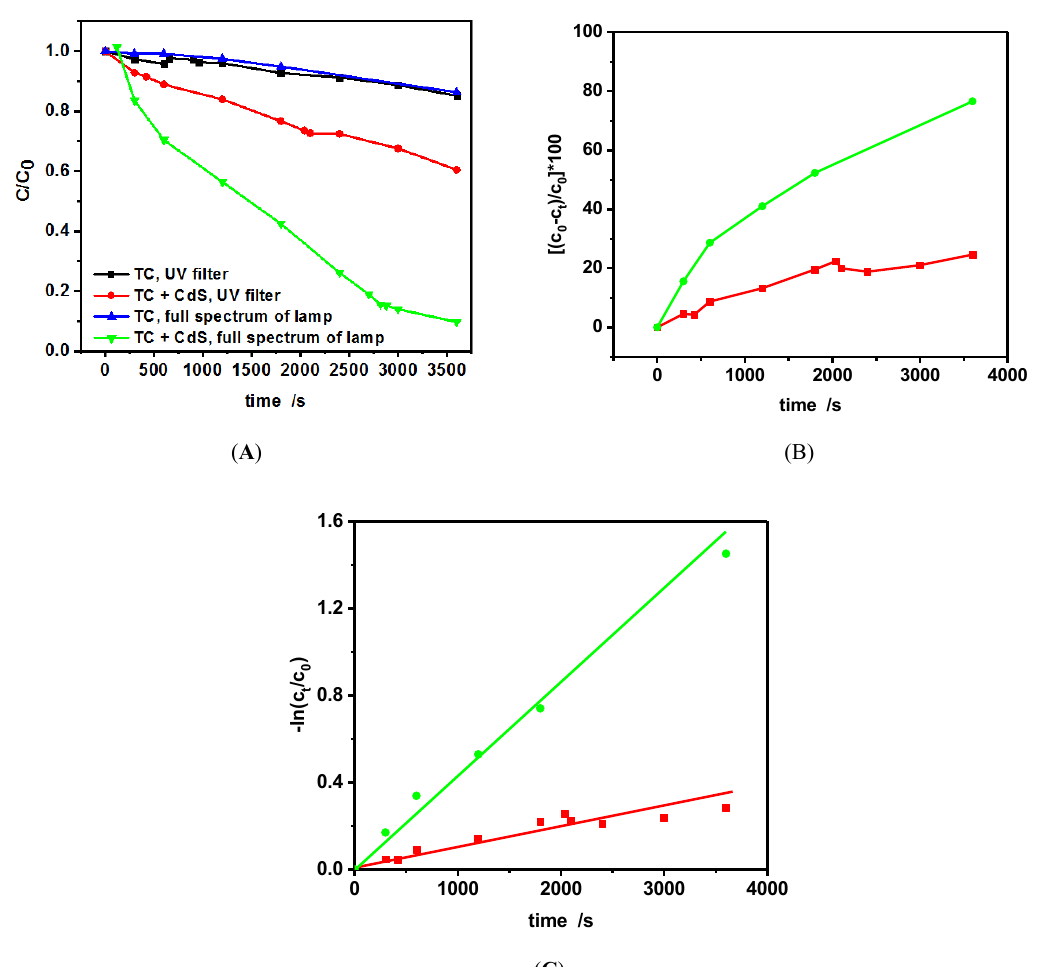
Figure 10. Degradation efficiency of TC: ( A ) plot of C t /C 0 vs. irradiation time; ( B ) plot of (C 0 − C t )/C 0 × 100 vs. irradiation time; ( C ) plot of ln(C 0 /C t ) vs. irradiation time. Black and blue curves correspond to TC degradation without CdS, while red and green curves are related to TC degradation in the CdS presence. Blue and green curves recorded with the full spectrum of the lamp, while red and black curves were recorded with the use of a UV filter.